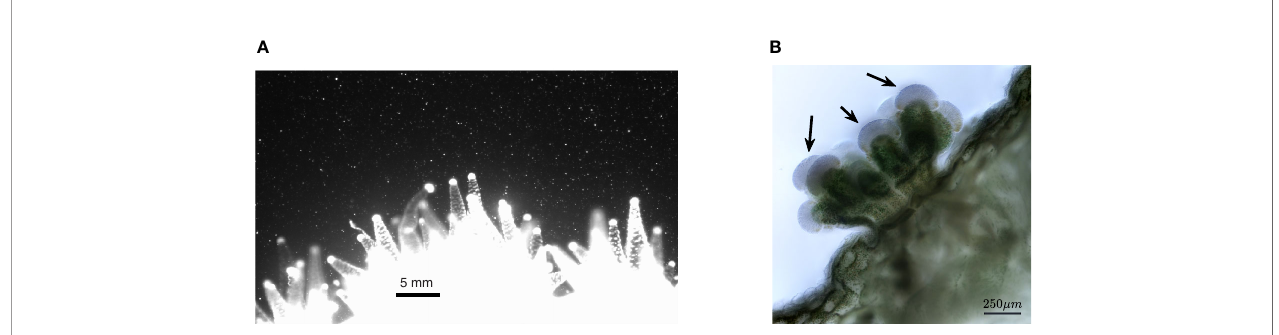
FIGURE 6 | (A) Image of a D . favus colonytaken in the laboratory. The colonyissmaller than the in-situ colonies shown in Figures 1 , 2 . Batteries of nematocysts are shownas white spots distributed alongthe tentacles. The acrospheres are shownas knob-likewhite spheres at thetip of each tentacle. The nematocyst concentration in these acrospheres ishigh,resulting inopticalsaturation.Photo byDror Malul. (B) In-vivo light microscopy imagingof Stylophora pistillata polyp/tentacle. A dense layer of nematocytes isshown at the acrospheres at the tip ofthe tentacle(see arrows).The green color isdue to the alga symbionts.